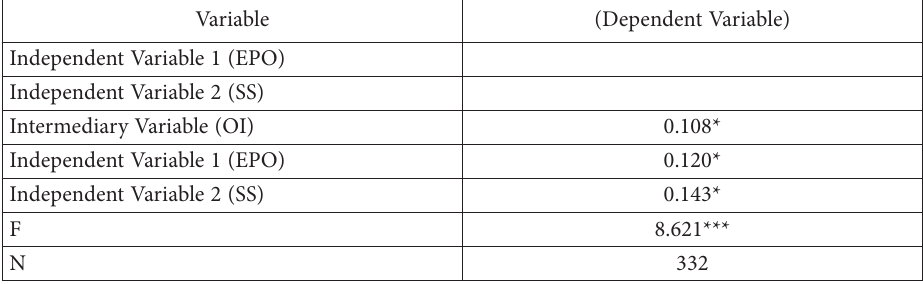
Table 4. Model coefficient (direct effect) (source: authors’ illustration) Variable (Dependent